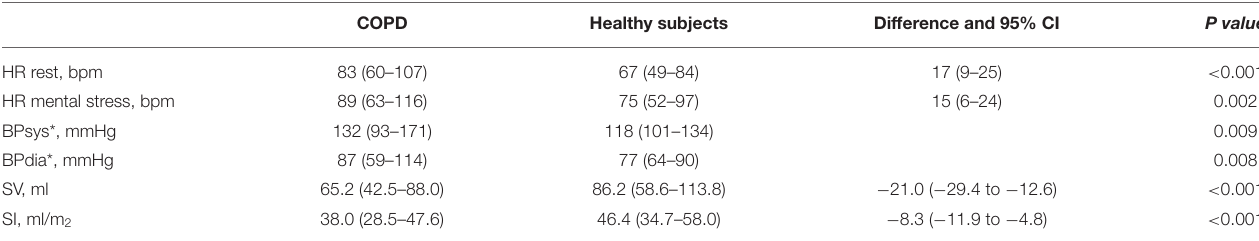
Differences are indicated as mean differences between arithmetic means with 95% CI. Comparison was performed using the unpaired t-test, except * the Kruskal-Wallis-test. COPD, chronic obstructive pulmonary disease; HR, heart rate; BPsys, systolic blood pressure; BPdia, diastolic blood pressure; SV, stroke volume during rest; SI, stroke index during rest; CI, confidence